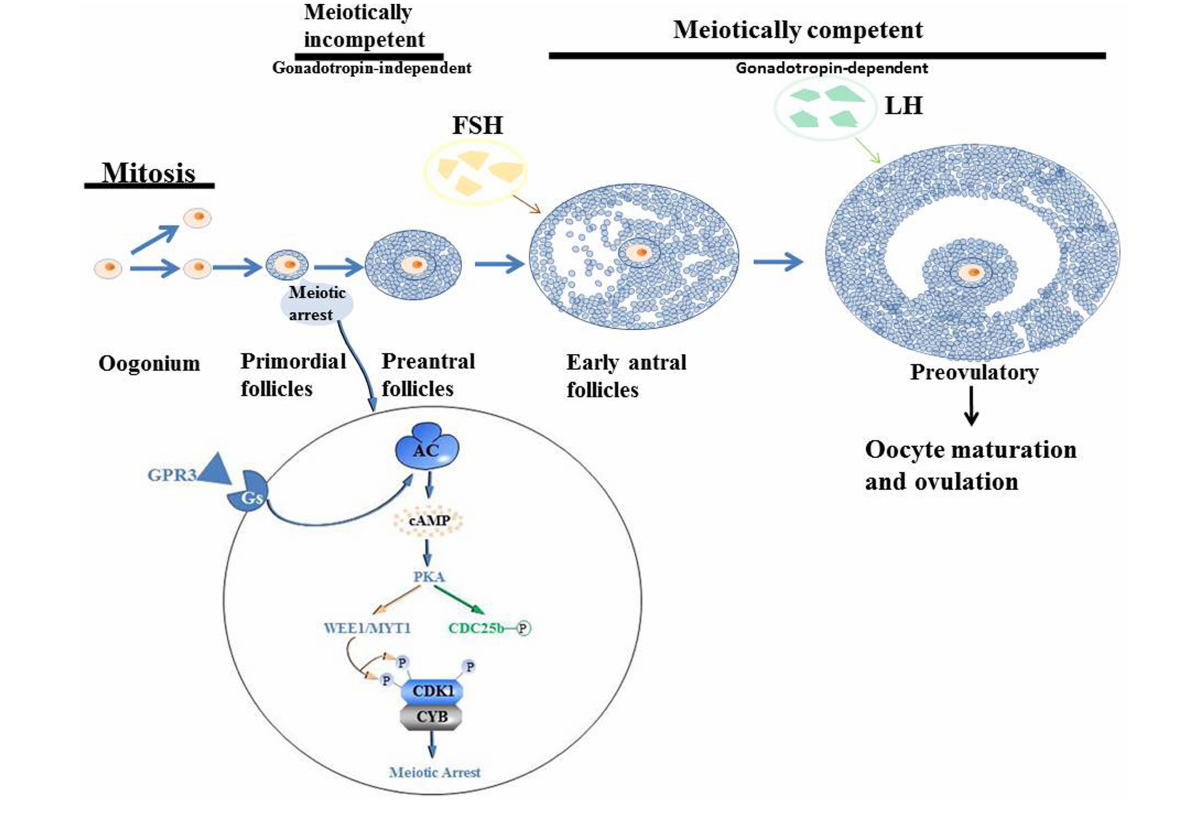
FIGURE 3 | Schematic illustration of the oogenesis.